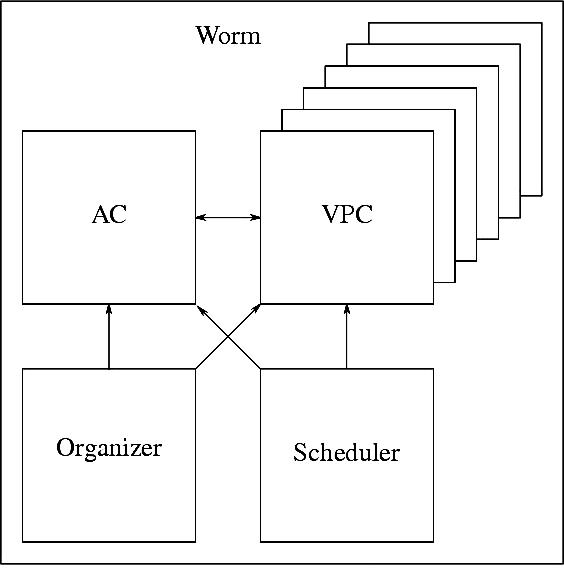
Modules Composing the Worm Vulva ModelCommunication between modules is marked by arrows. Communication between VPCs is not depicted.